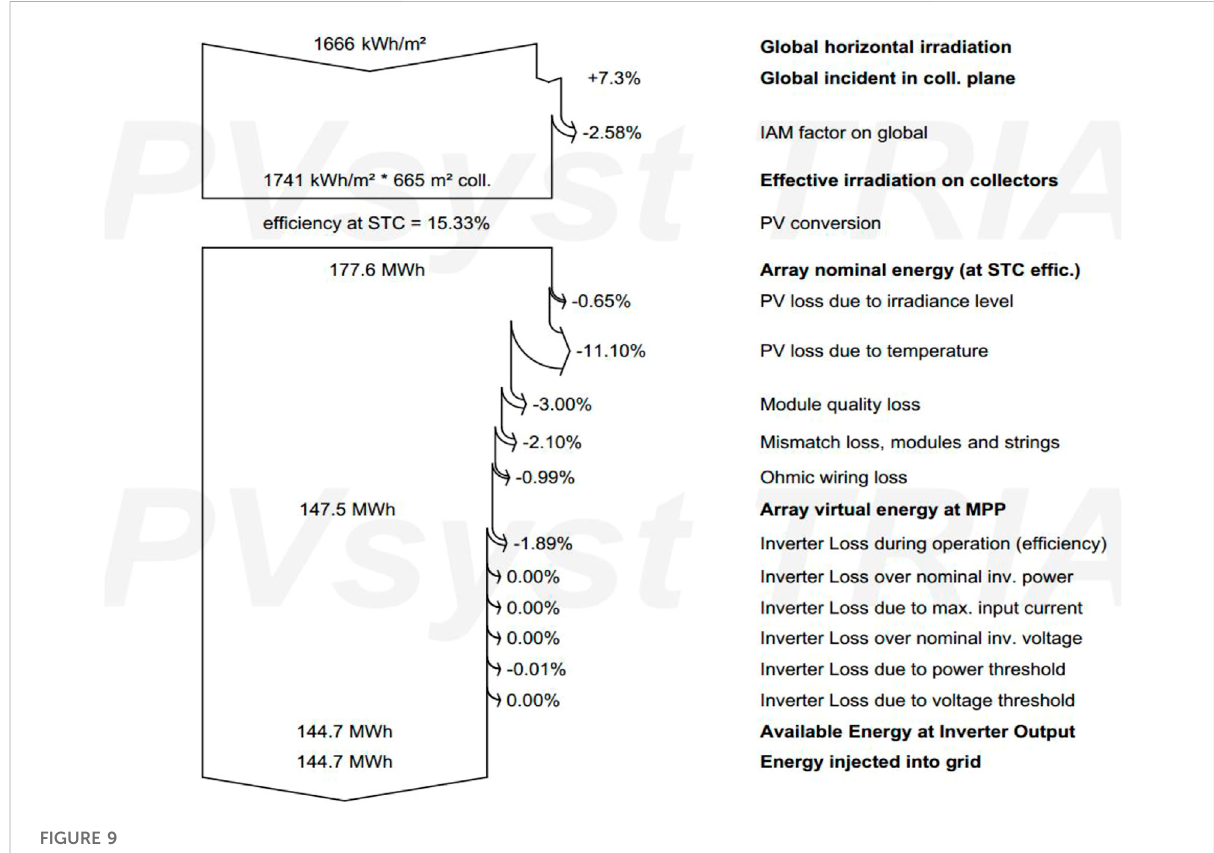
FIGURE 9 Arrow loss diagram of the PV plant.